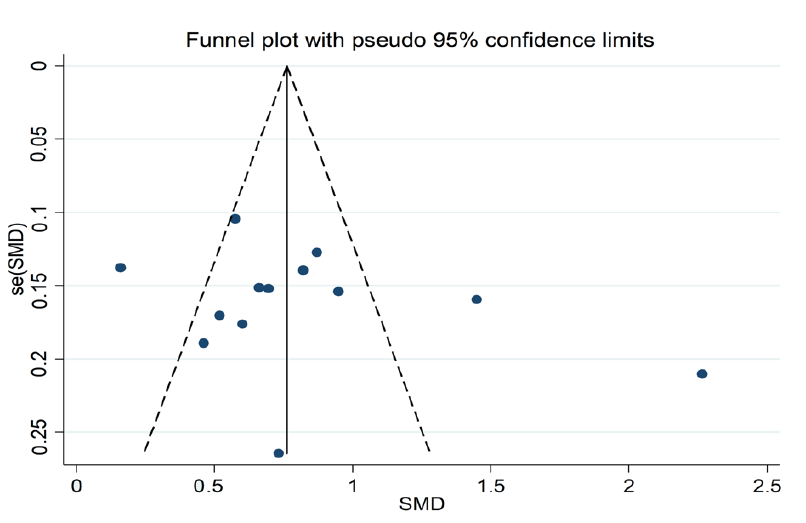
Figure 10. Funnel plot of studies investigating neutrophil-to-lymphocyte ratio values in AECOPD patients with and without adverse outcomes.